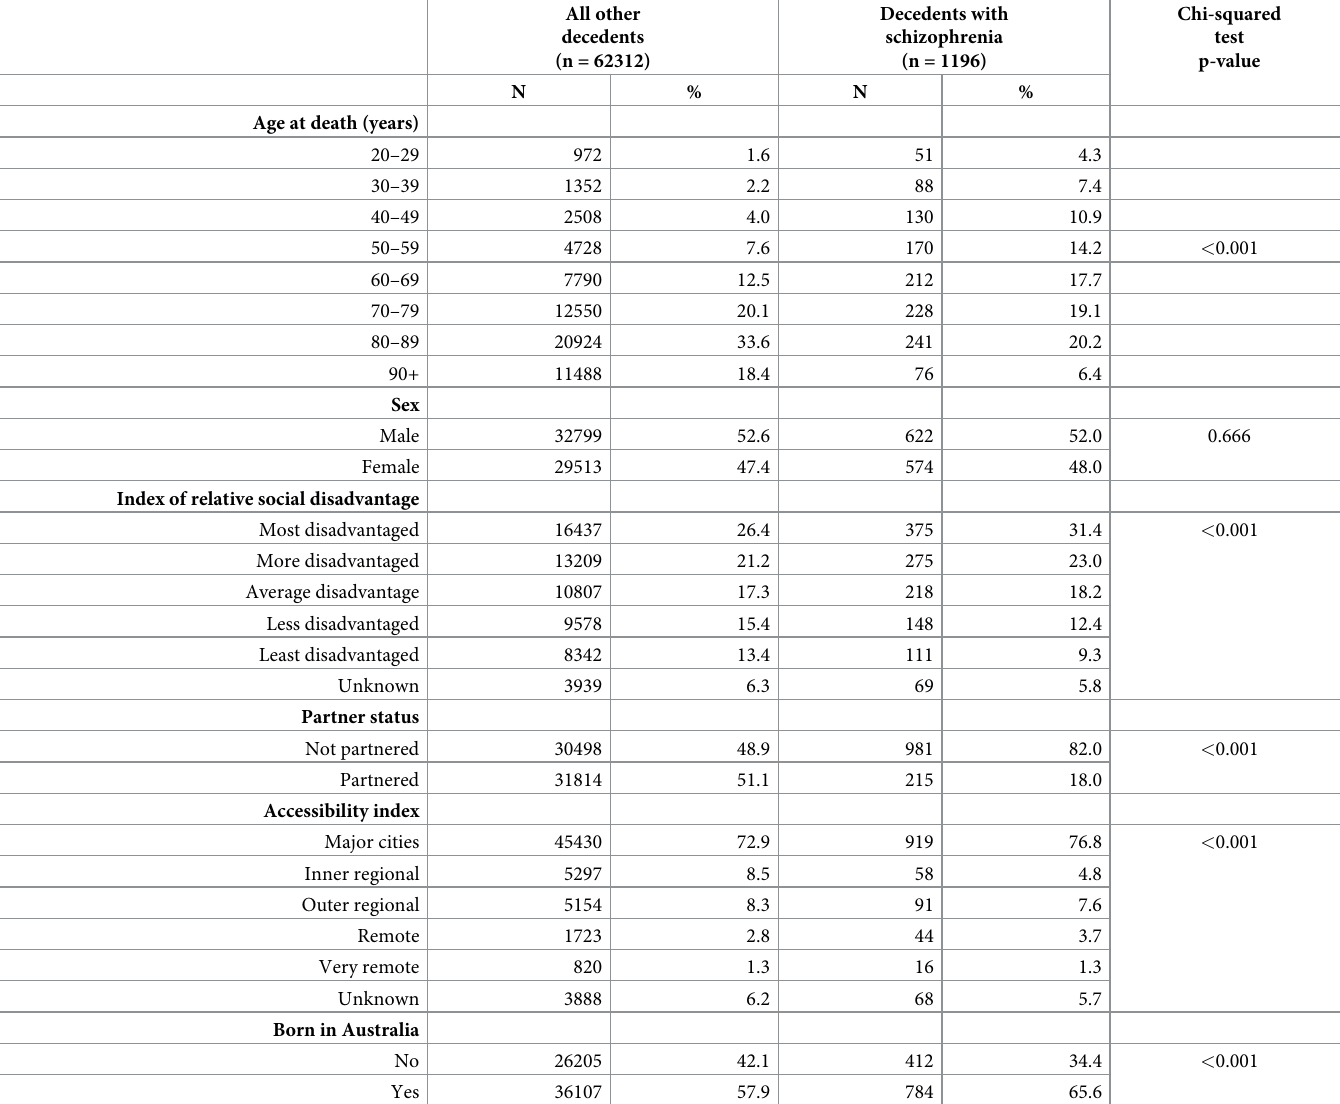
Table 1. Socio-demographic characteristics at time of death for decedents with schizophrenia compared to all other decedents who died over the same time five- year time period